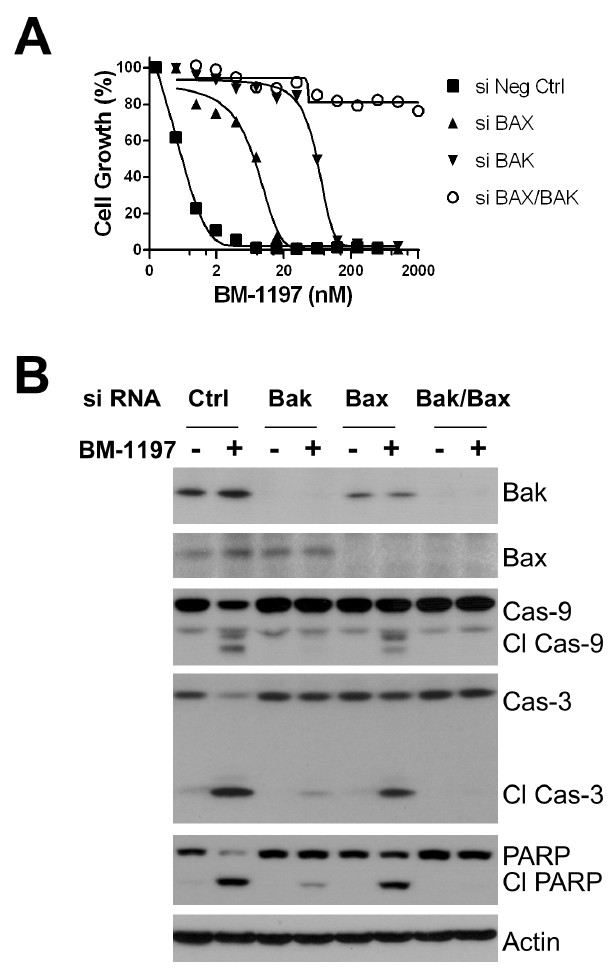
Figure 6. BM-1197 induces BAX/BAK-dependent apoptosis in MEF/ MCL1 2 / 2 cells. (A) MCL1 2 / 2 cells were transfected with Bax- and/ or Bak-specific siRNAs for 2 days then treated with BM-1197 for another 2 days. The growth-inhibitory activity of BM-1197 was evaluated by WST assay. Data are mean 6 SD, and are representative of at least three independent experiments. (B) MCL1 2 / 2 cells were transfected with mouse Bax- and/or Bak-specific siRNAs for 2 days then treated with BM- 1197 (50 nM) for 20 h. Whole cell extracts were analyzed